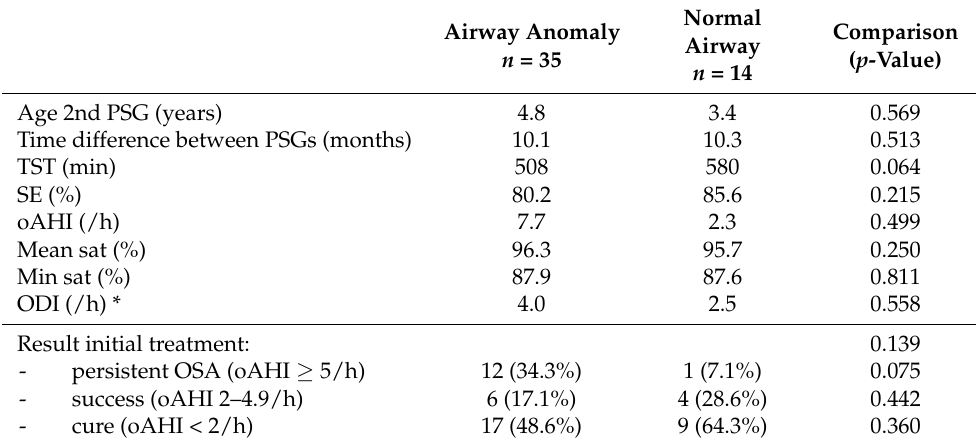
Figure 2. Comparison of OSA severity between the patients with and without airway anomalies. Table 2. Comparison of the results from the first follow-up PSG after treatment between the group with and without lower airway